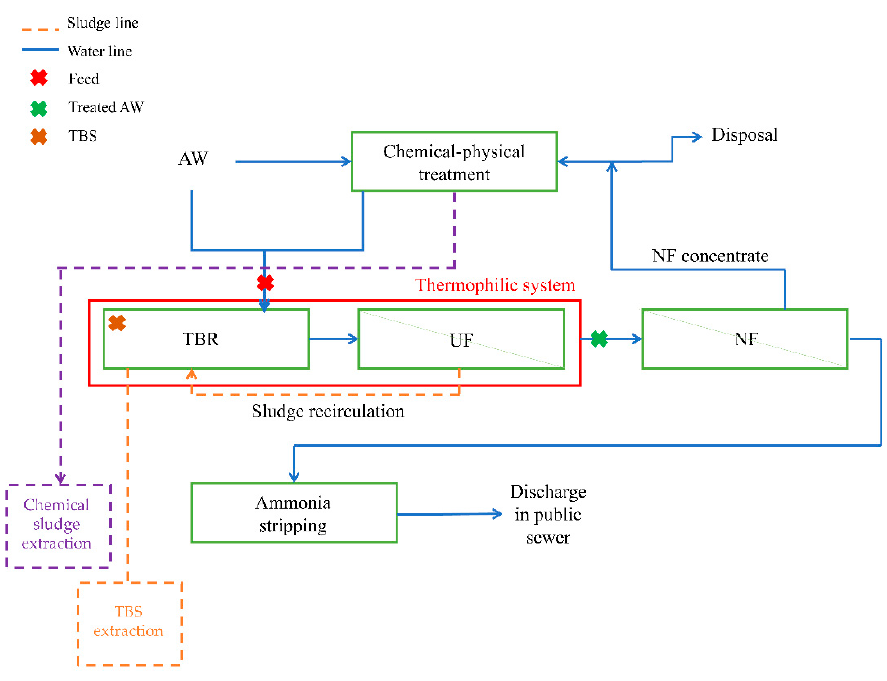
Figure 1. Scheme of the AWTP and sampling points (X). AW: Aqueous waste; NF: Nanofiltration; TBR: Thermophilic biological reactor; TBS: Thermophilic biological sludge; UF: Ultrafiltration.